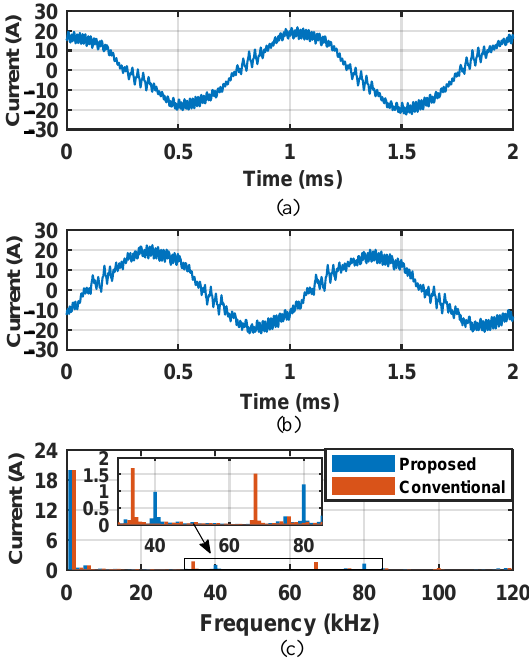
Figure 20. The phase current. ( a ) The phase current of proposed SVPWM algorithm. ( b ) The phase current of conventional SVPWM algorithm. ( c ) The harmonic of the